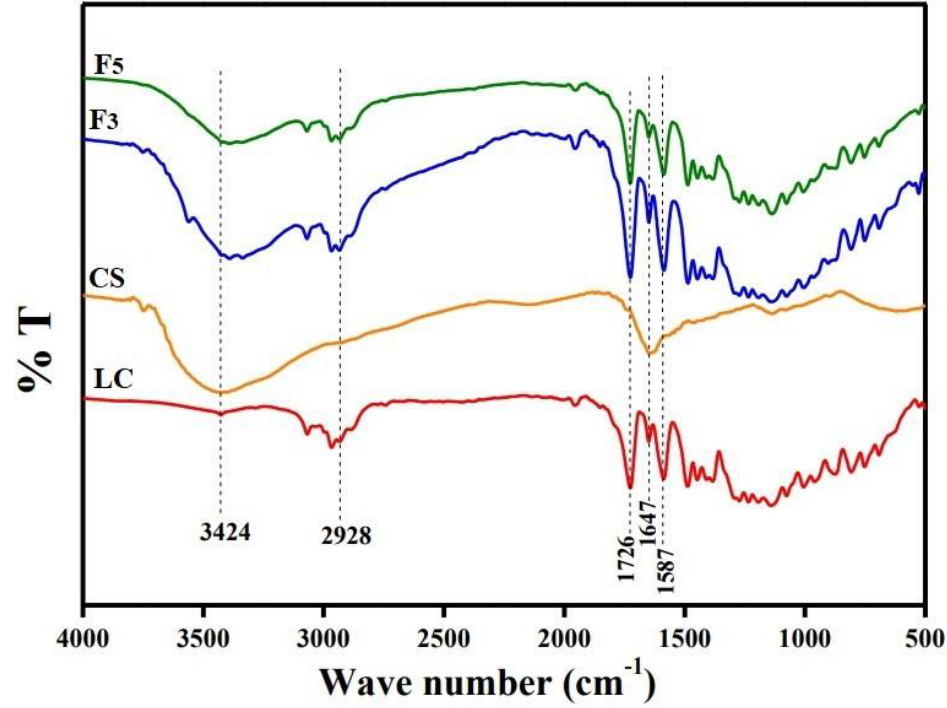
Figure 3. FTIR spectra of LC, CS, CS/TPP-loaded LC nanoparticles (F3) and CS/ALG − loaded LC nanoparticles (F5).